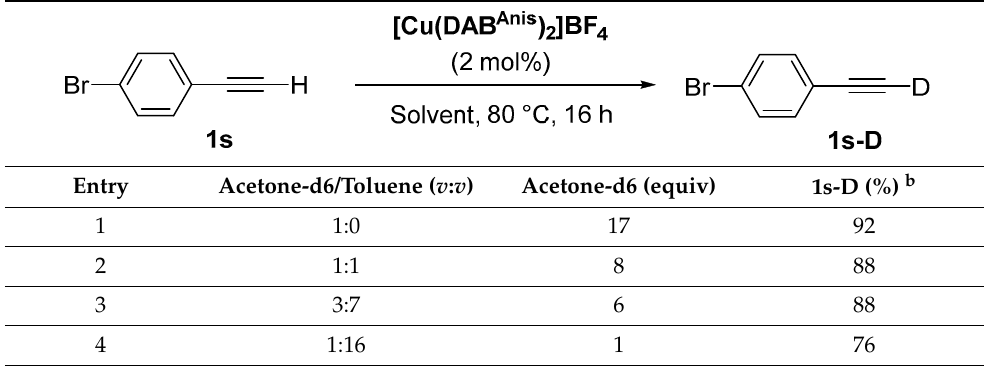
Table 4. Additional solvent optimisation a .